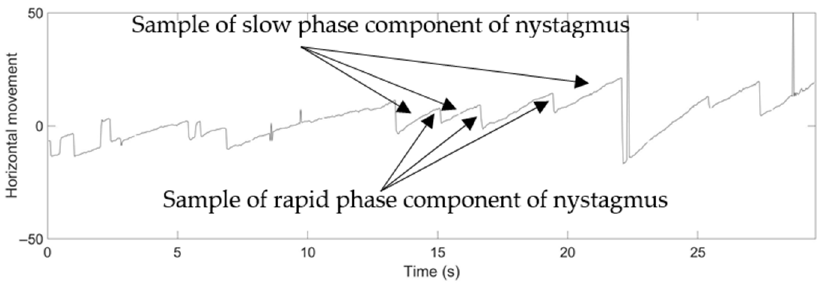
Figure 19. Nystagmus waveform from the proposed method for Video No. 11, horizontal movement of the pupil.